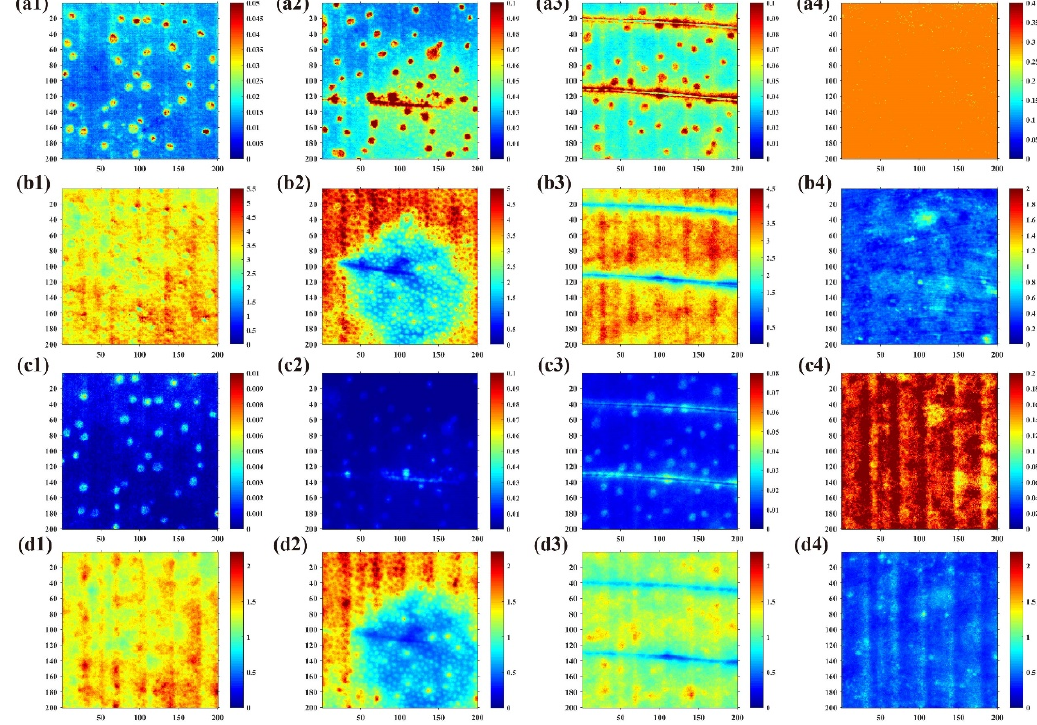
Figure 8. ( a1 – a4 ) and ( b1 – b4 ) are the μ a and μ ’ s maps of normal, bruised, scratched, and abraded pears at 527 nm, respectively; ( c1 – c4 ) and ( d1 – d4 ) are the corresponding μ a and μ ’ s maps at 675 nm, respectively.